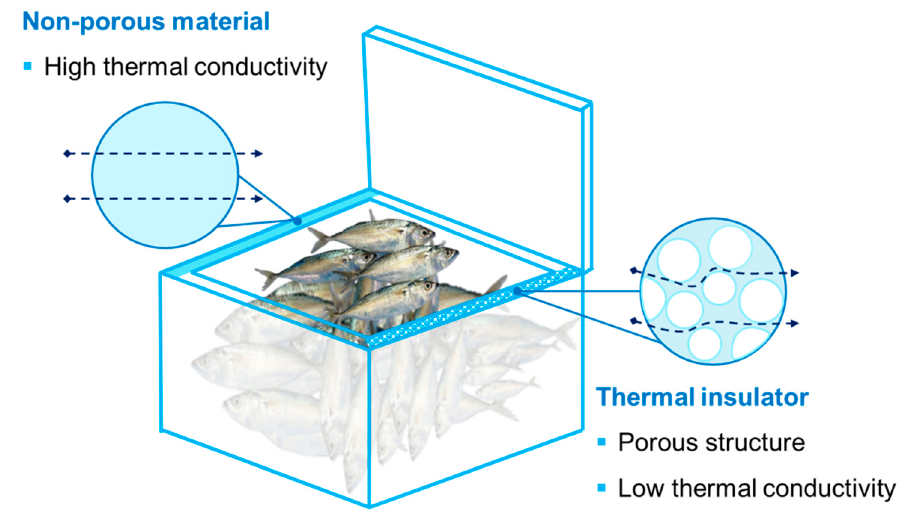
Figure 7. Insulator box containing numerous pores, giving low thermal conductivity to maintain the cold temperature of seafood products. Table 4. Patents related to thermal insulators and box packaging for fishery